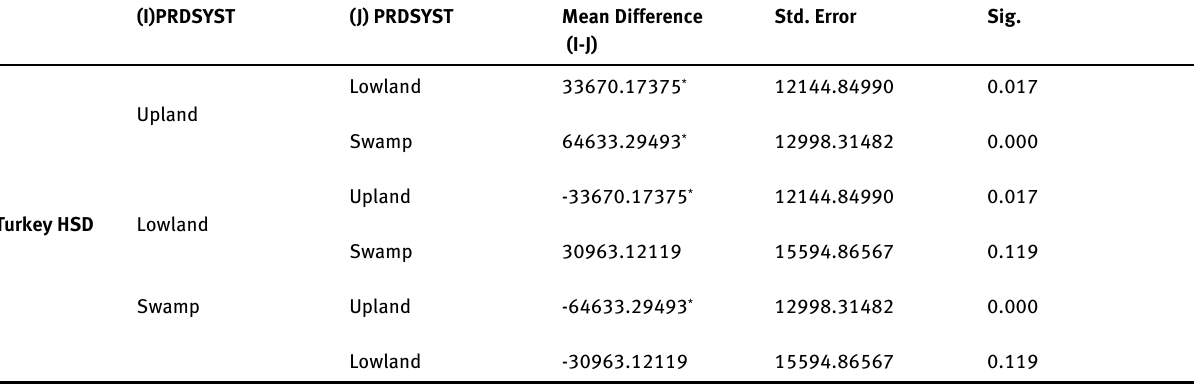
Table 8: Post Hoc comparison of mean difference in profits earned by rice farmers in different production systems Dependent Variable: